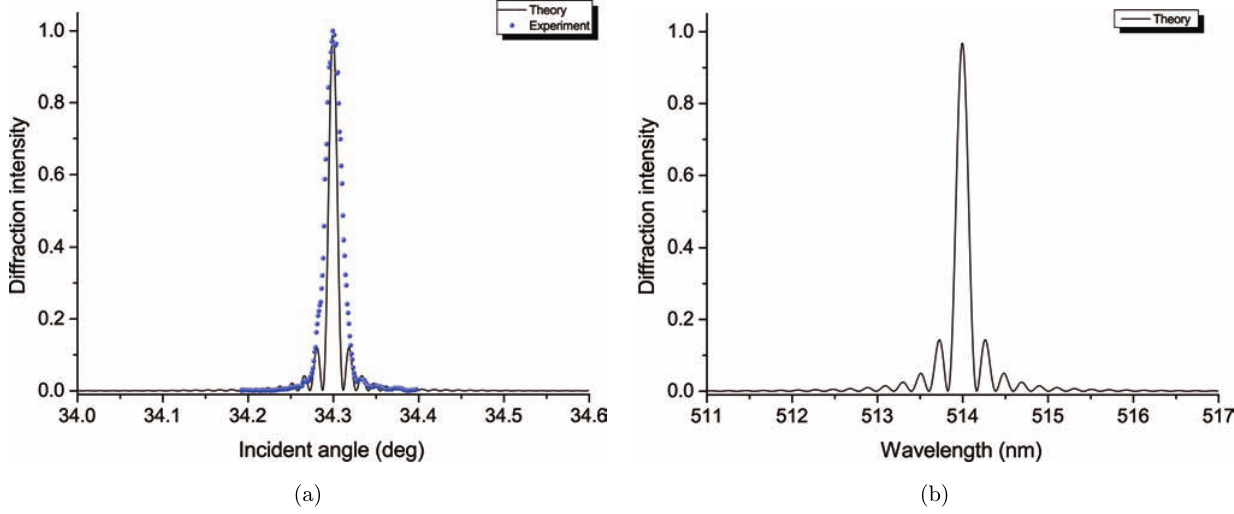
Fig. 1. (a) The normalized experimentally measured di®raction intensity and simulation result of the angular selectivity curve of the single transmission VHG. (b) Numerical simulation result of the wavelength selectivity of the single transmission